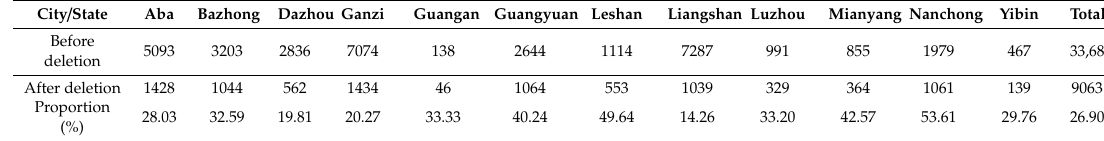
Table 5. Sample screening changes.